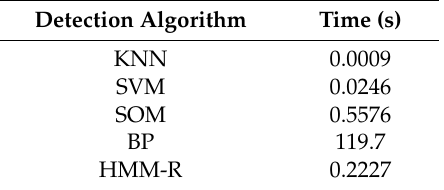
Table 6. Detection time of each algorithm in window 40 with attack ratio of 0.025.